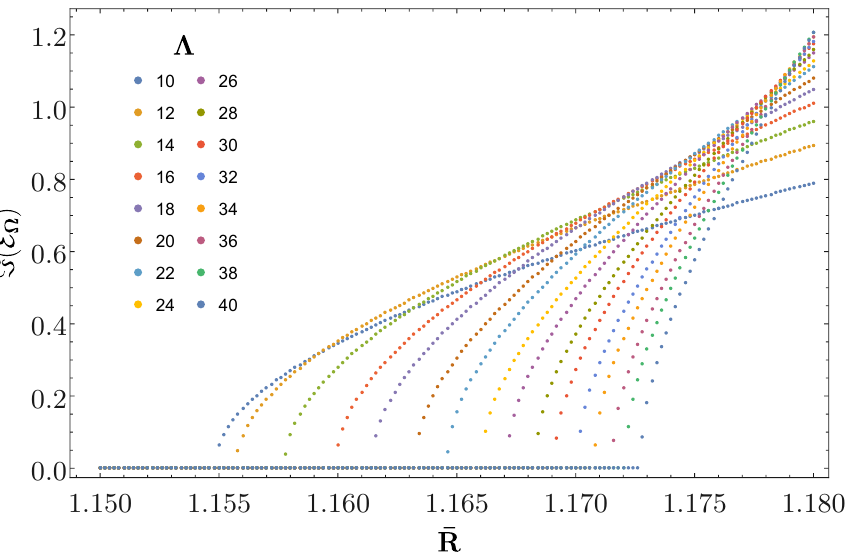
Figure 17. Imaginary part of the vacuum energy in the Lee-Yang model as a function of the radius of AdS, for different